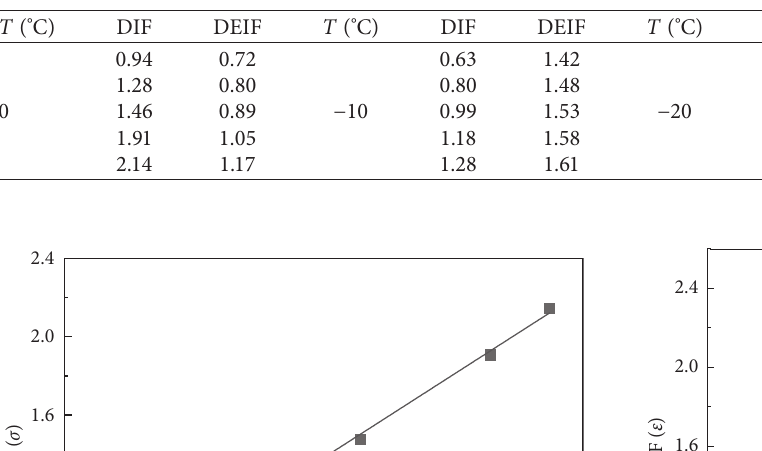
Table 3: DIF and DEIF values of samples at different frost temperatures.